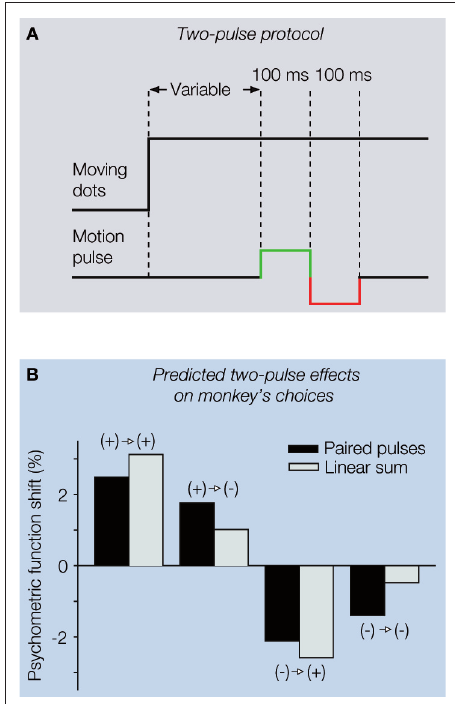
Figure 5 | Multiple pulse protocol and predictions of the attractor model. (A) One out of four possible combinations of the double-pulse experimental protocol proposed in Wong et al. (2007). (B) Model predictions for double-pulse effects on monkey’s choices. Second pulse has a weaker effect than the first, resulting in differential effects between the paired-pulse from the linear sum of the individual pulses. (A,B) adapted from Wong et al.